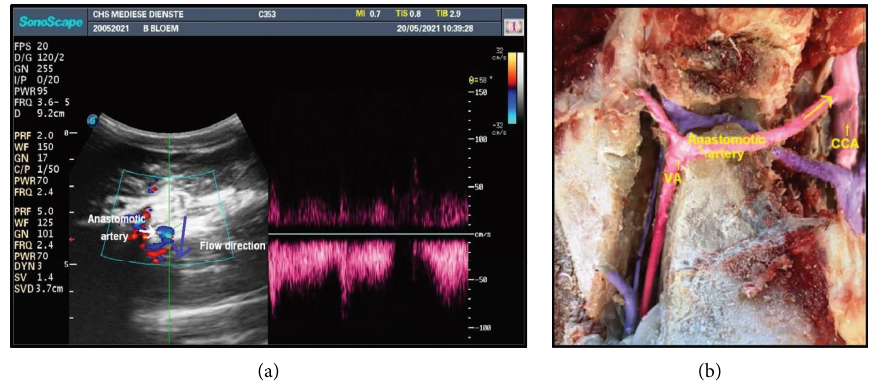
Figure 4: (a) Doppler waveform with color fow images demonstrated preferential fow in the anastomotic artery directed away from the vertebral artery towards the common carotid artery in the head upright position. (b) Visual illustration of the latex model during detailed dissection of the carotid-vertebral anastomosis with the direction of fow (yellow arrow) away from the vertebral artery (VA) towards the common carotid artery (CCA), in the head upright